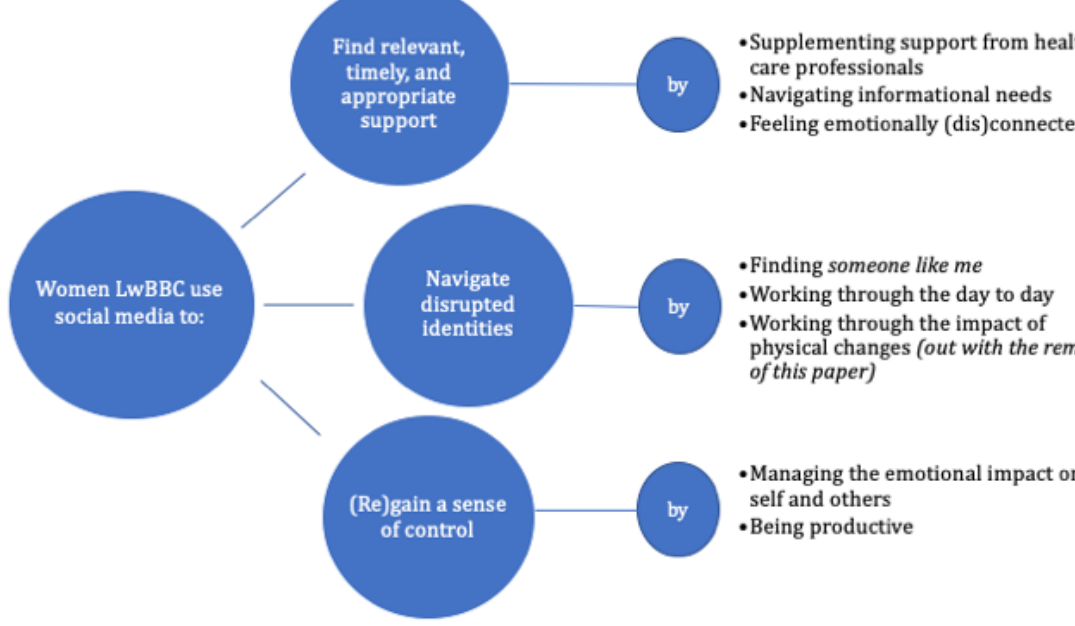
Figure 2. Thematic map: women's use of social media to support self-management when living with and beyond breast